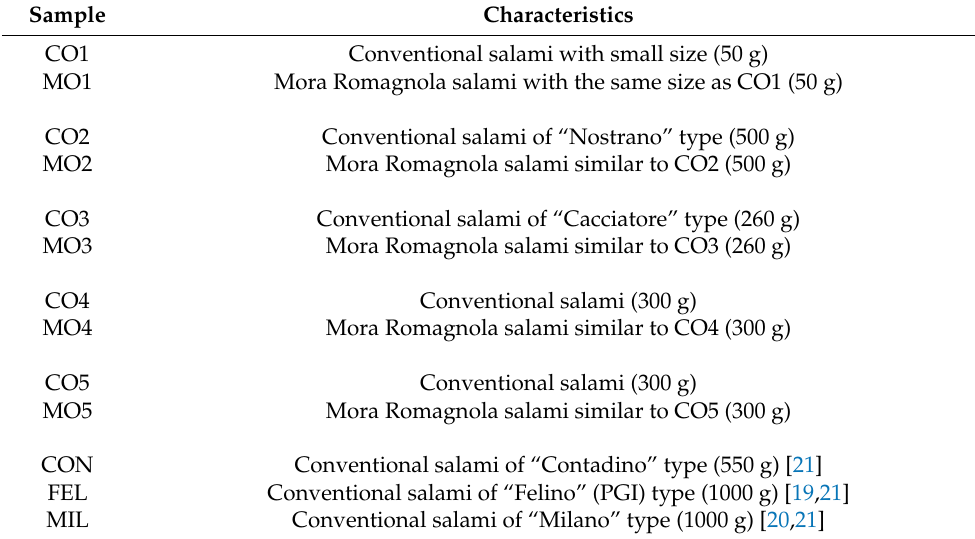
Table 1. Characteristics of salami